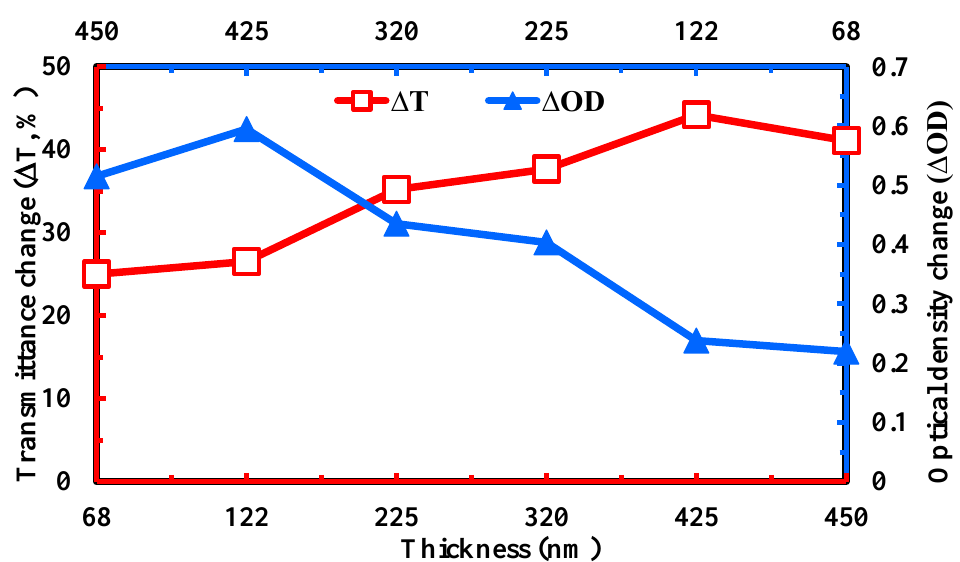
Figure 9. Transmittance change ( ∆ T, bottom-left axes) and optical density change ( ∆ OD, top-right axes), with respect to their different thicknesses of WO 3 films.